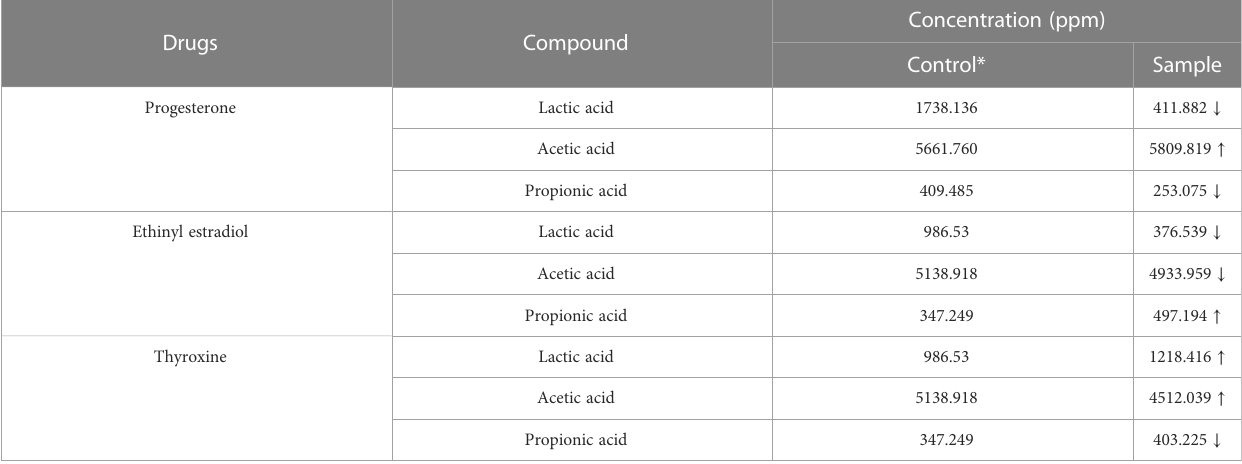
TABLE 1 The concentration of SCFAs and lactic acid produced by Bacteroides fragilis under the effect of hormonal drugs (progesterone, ethinyl estradiol, and thyroxine) measured by